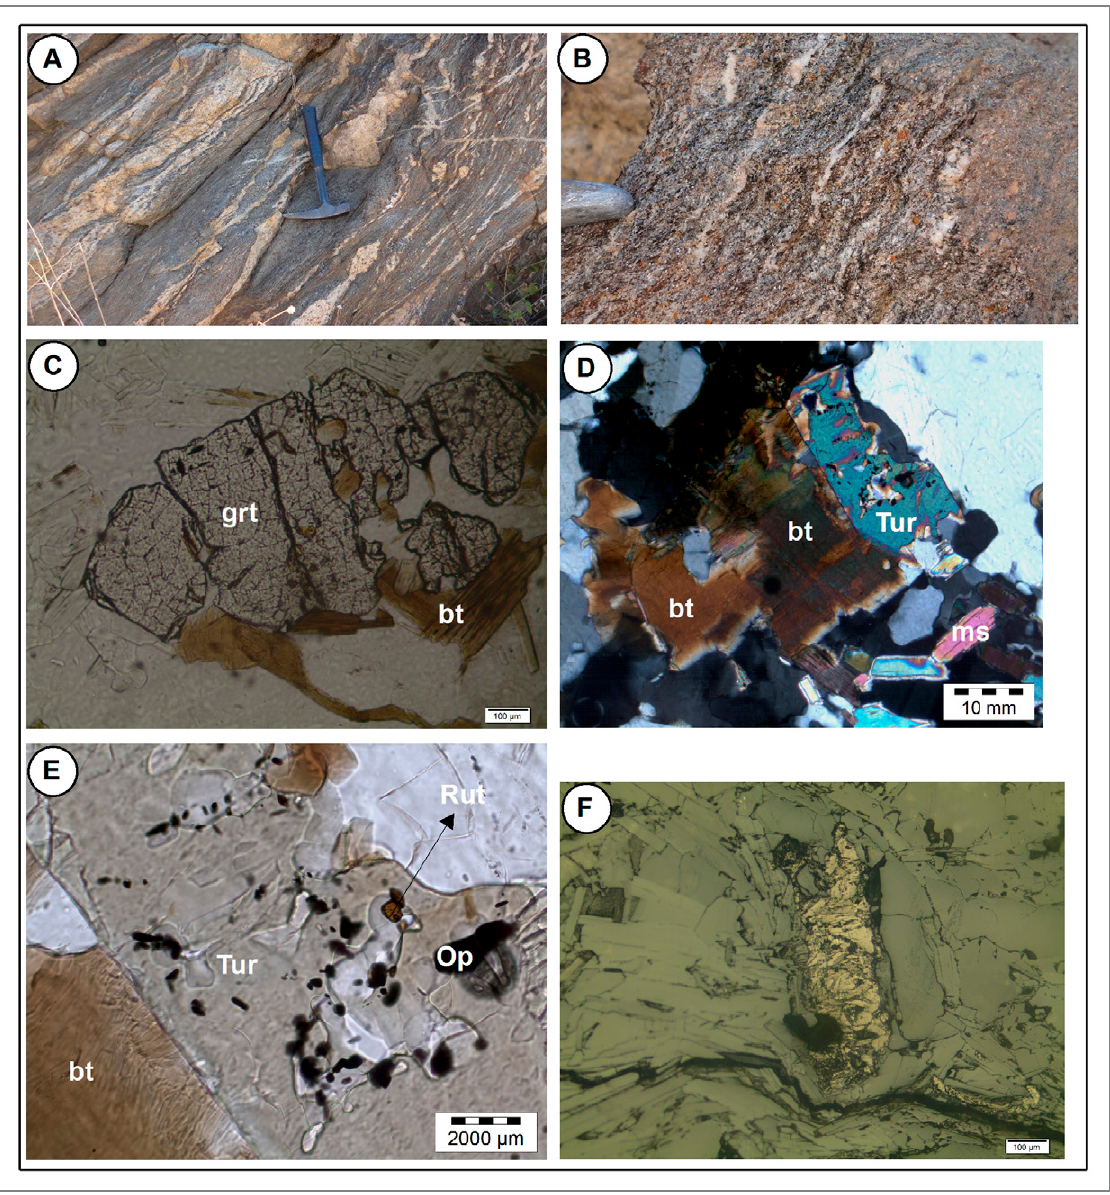
FIGURE 3 – (A) Field photograph of the migmatitic paragneiss from the Jaguaretama Complex; (B) detail for the paleosome with garnet porphyroblast; (C) Photomicrography with features of biotite (bt) inclusion in garnet (grt) porphyroblast from a paleosome sample; (D) Photomicrography showing detail for tourmaline, biotite and muscovite from a quartz-feldspathic leucosome vein (E) Photomicrography